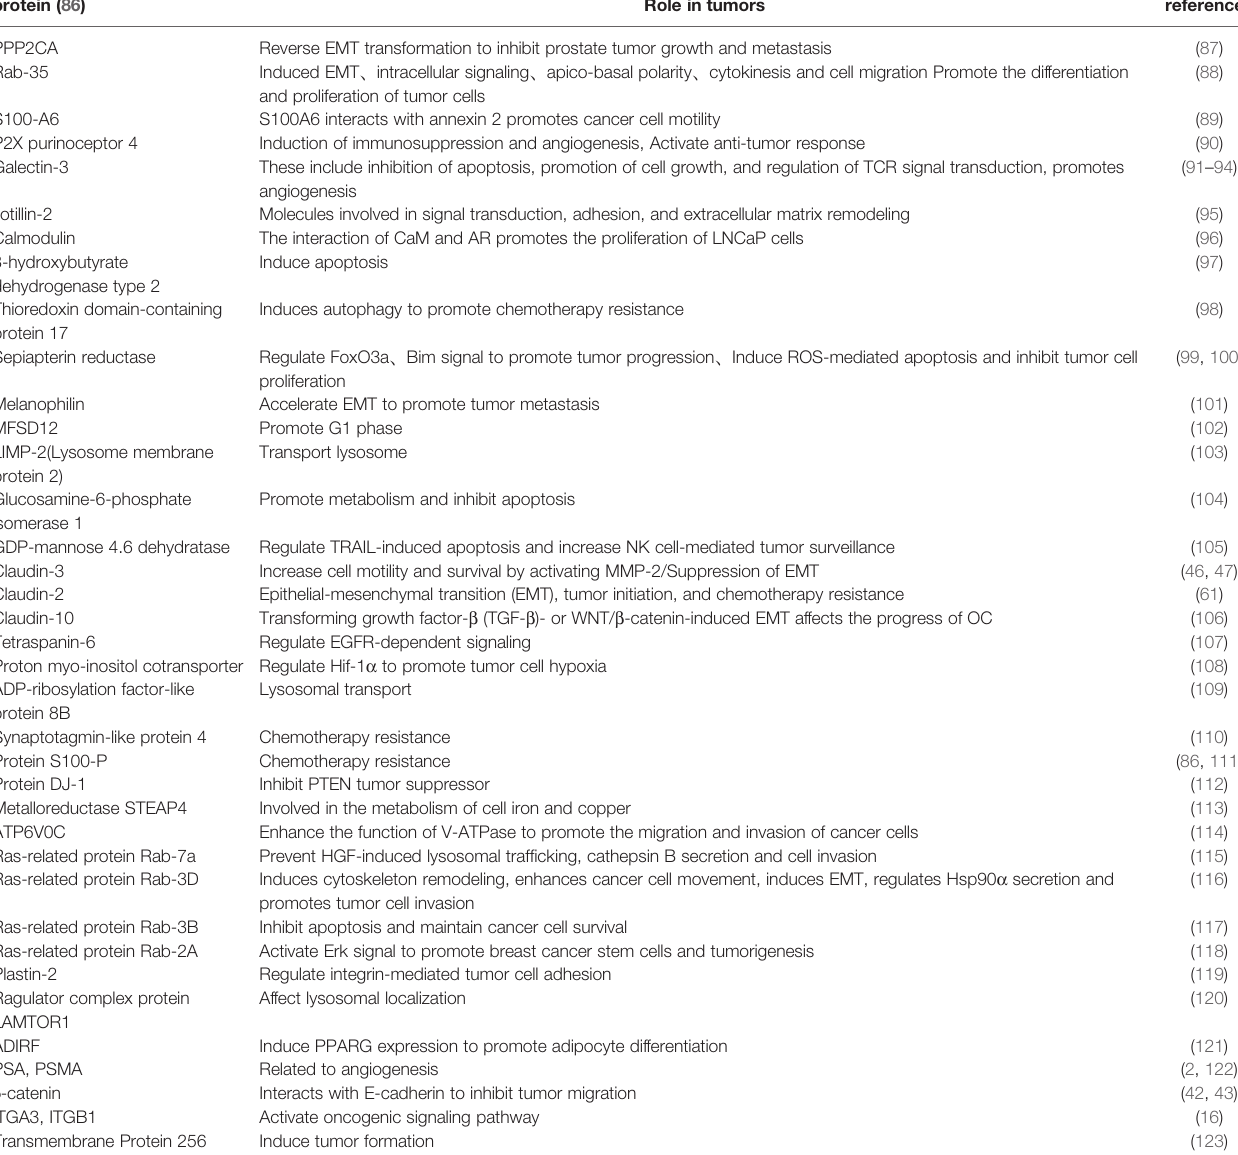
TABLE 3 | Exosomal protein in urine of prostate cancer